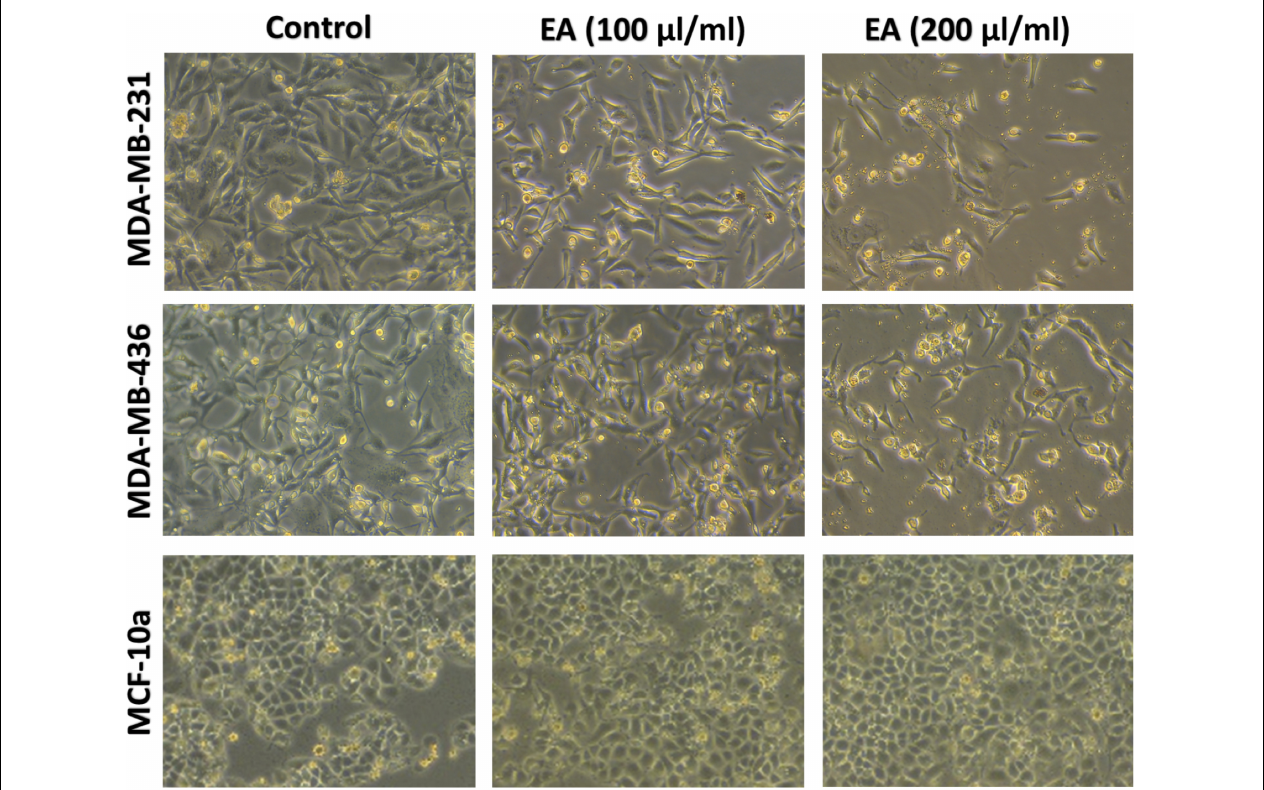
FIGURE 2 | Effect of EA extract on cell morphology of MDA-MB-231, MDA-MB-436 and MCF 10A. We note that treatment for 48 h with 100 and 200 µ l/ml of EA extract inhibits cell proliferation and induces death in both cell lines, in comparison with untreated (control) which show no cytotoxic effect and display a healthy fibroblast-like phenotype cell. Images were taken at 10x